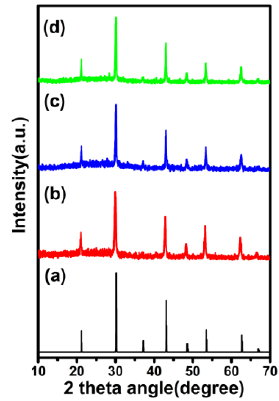
Figure 1. XRD patterns of ( a ) standard KMnF 3 (JCPDS-82-1334), ( b ) KMnF 3 :18%Yb 3+ ,1%Er 3+ nanoparticles (NPs), ( c ) KMnF 3 :18%Yb 3+ ,1%Er 3+ @ KMnF 3 NPs, and ( d ) KMnF 3 :18%Yb 3+ ,1%Er 3+ @KMnF 3 :2%Yb 3+ NPs.